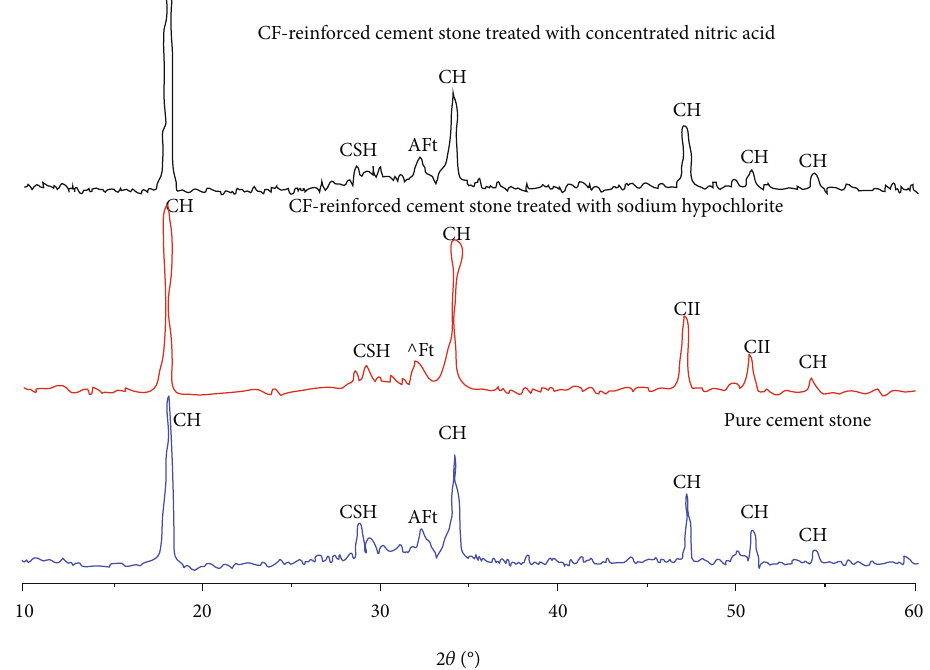
Figure 5: XRD pattern of cement stone with 0.2% CF cured for 7 days.